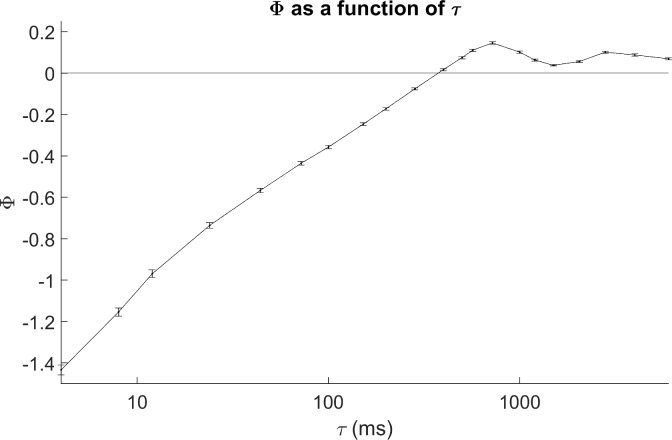
Φ as a function of τ.Mean and standard error of Φ as a function of temporal scale τ. Results were pooled across groups (FNI and SC) and sleep states (AS and QS).